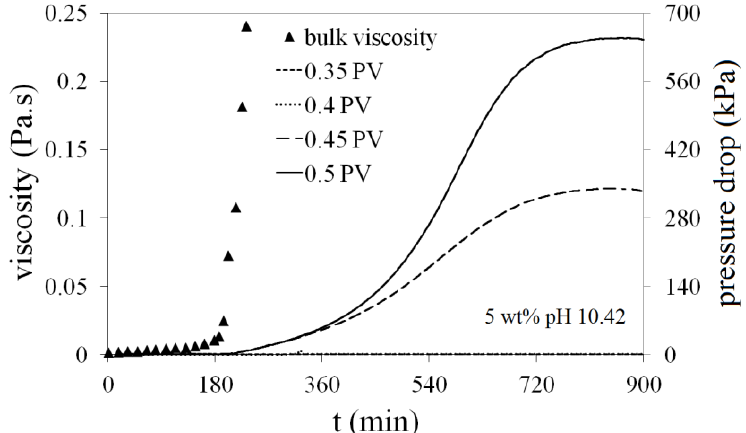
Figure 9. Pressure drop in sand-pack A as a function of time after placement of Na-silicate gel (5 wt% at pH = 10.42) at the middle of sand-pack. The results are compared for different Na-silicate slug sizes. The bulk measured viscosity for the tested Na-silicate sample is also